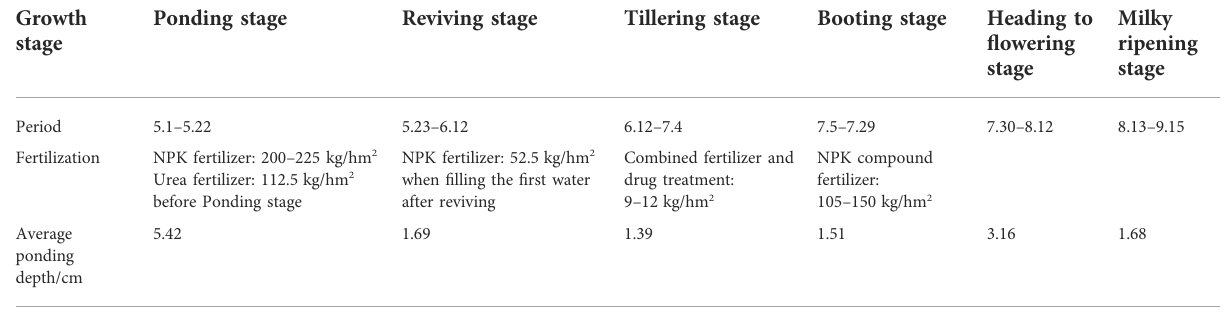
TABLE 2 Growth stage and fertilization of